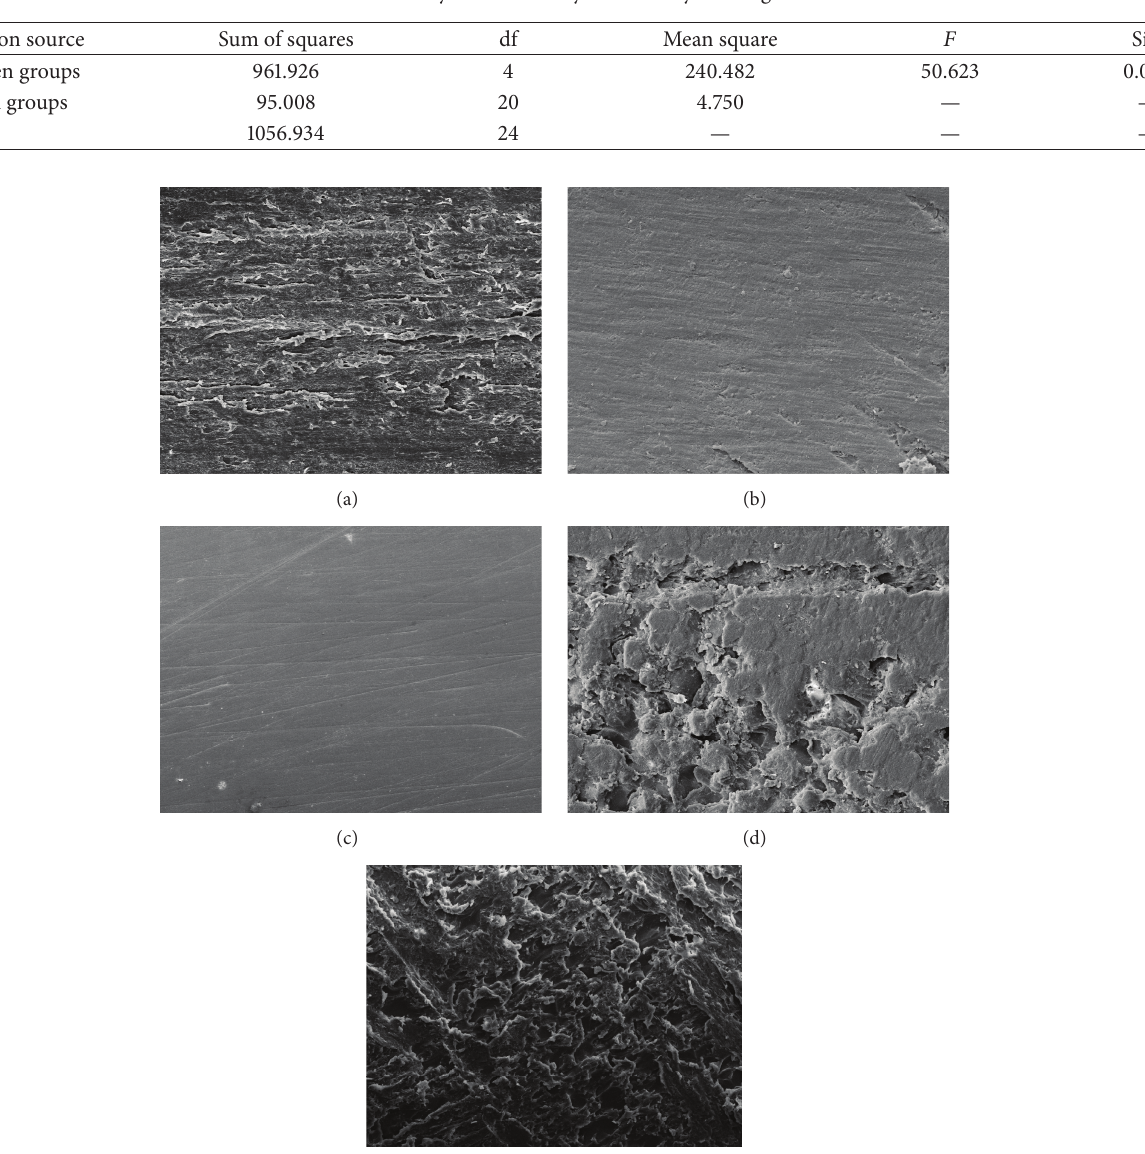
Table 4: One-way ANOVA analysis of colony forming units.